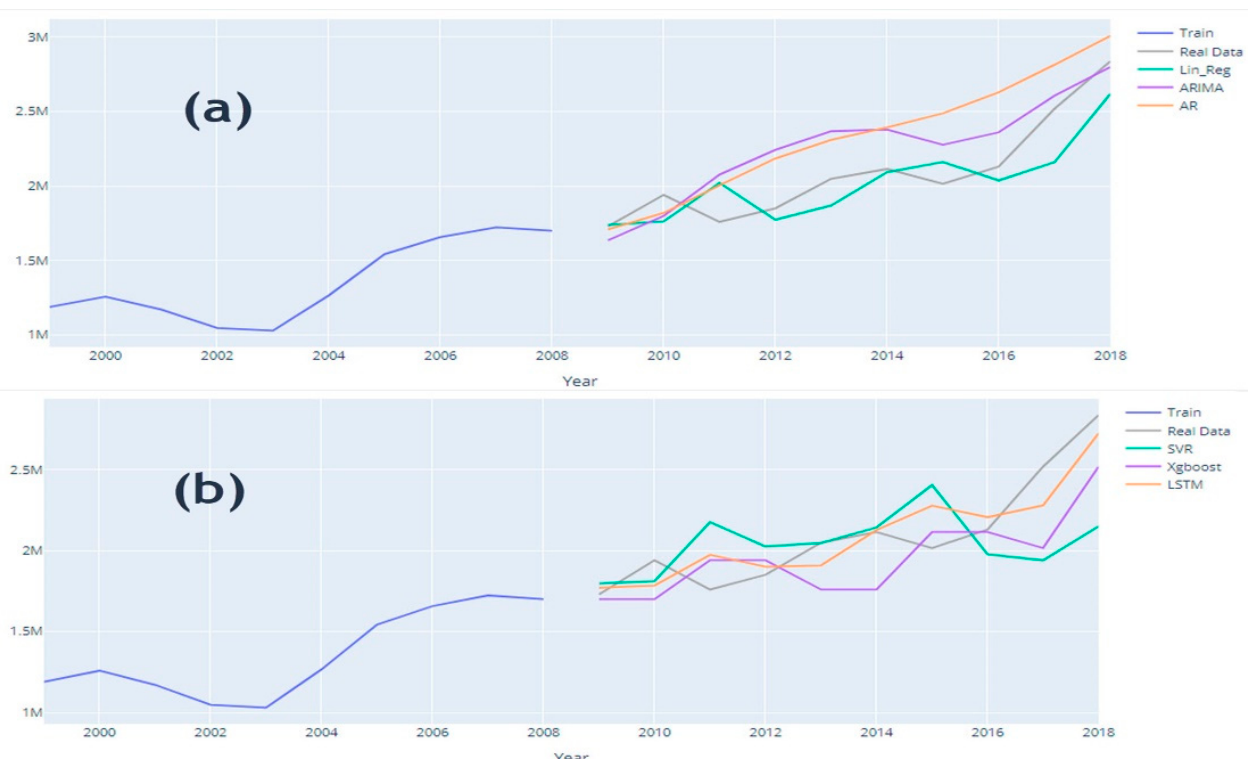
Figure 4. Forecasting results for the Marrakech-Safi region with all models: ( a ) Shows the forecasting results for the Marrakech-Safi region of the three conventional methods with the real data; ( b ) shows the forecasting results for the Marrakech-Safi region of the three AI-based models with the real data.